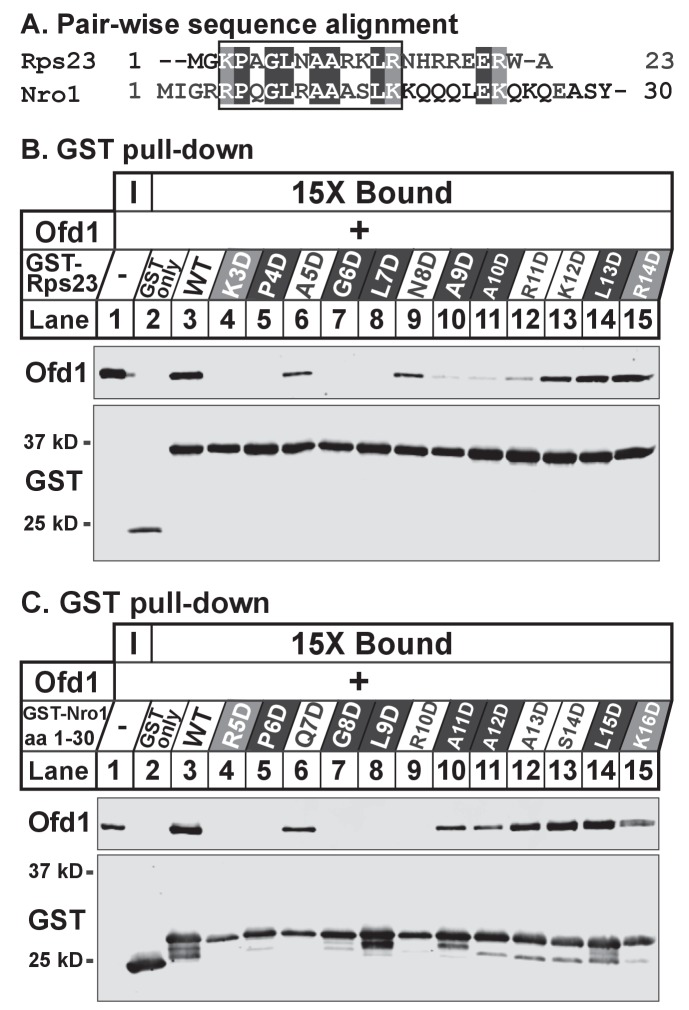
Identification of an Ofd1 binding sequence.(A) Pair-wise alignment of Rps23 (aa 1–23) and Nro1 (aa 1–30) sequences required to bind Ofd1; black boxes denote identical residues and gray boxes denote similar residues. Amino acids enclosed by the box were individually mutated and tested for binding to Ofd1. (B, C) Lysates of bacteria expressing wild-type or mutant GST-Rps23 FL (B) or GST-Nro1 aa 1–30 (C) were incubated with glutathione beads prior to incubation with purified Ofd1 (84.5 nM). Input and bound fractions were analyzed by immunoblot using antibodies against Ofd1 and GST. Shown are representative blots from one of at least two independent experiments.